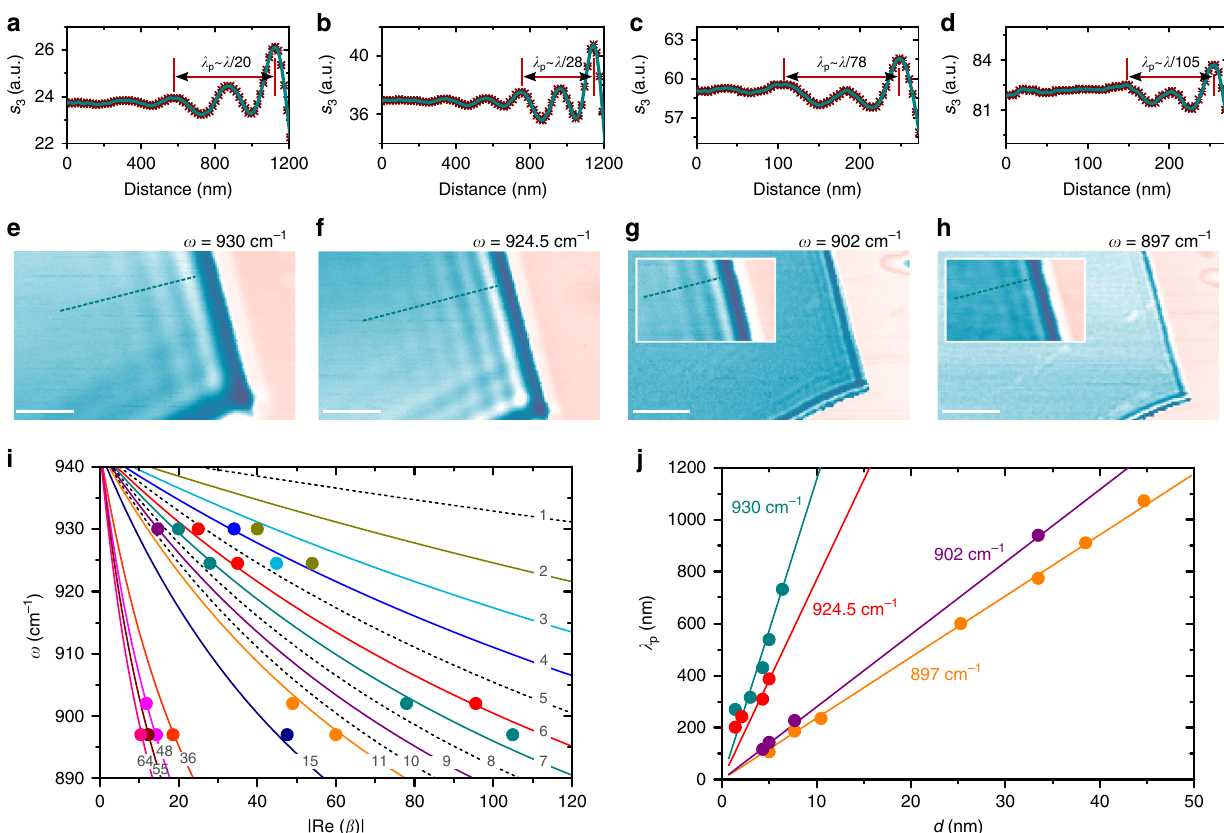
Fig. 2 Infrared nano-imaging, dispersion and scaling of MoS 2 – SiC SPhPs. a – h Near- fi eld images (optical amplitude s 3 ) of 7-layer MoS 2 on SiC ( e – h ) recorded at different laser excitation lines (marked as ω ), and corresponding cross-sections ( a – d ) along cyan dotted lines. Cyan and pink colours refer to MoS 2 crystal and the substrate (SiC) areas correspondingly. Cyan curves in images ( a – d ) serve as eye guide. Insets in images ( g , h ) show zoomed in fringes on the top right hand side part of MoS 2 – SiC boundary. Scale bars are 500 nm. i Calculated (solid/dotted curves) and experimental (circles) dispersion for different number of MoS 2 layers (labelled on each of the curves). Data corresponding to the same number of layers are marked with the same colour. j Calculated and experimental scaling of the SPhPs wavelength with MoS 2 thickness. Data corresponding to the same laser line are marked with the same